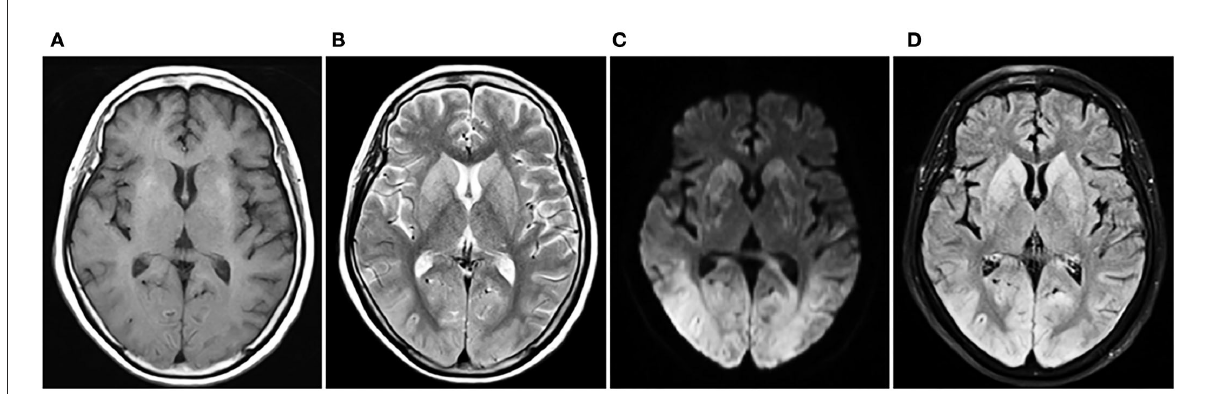
FIGURE3 Cerebral MRI contrast of ischemic hypoxic encephalopathy. T2WI and T2-FLAIR show extensive gyral swelling and hyperintensity in basal ganglia bilaterally. DWI demonstrates bilateral symmetrical diffusion restriction throughout the cortex of both cerebral hemispheres, particularly involving the perirolandic and occipital cortices. (A) T1WI, (B) T2WI, (C) DWI, (D) T2-FLAIR. MRI, magnetic resonance imaging; T1WI, T1-weighted imaging; T2WI, T2-weighted imaging; DWI, diffusion-weighted imaging; FLAIR, fluid-attenuated inversion recovery.